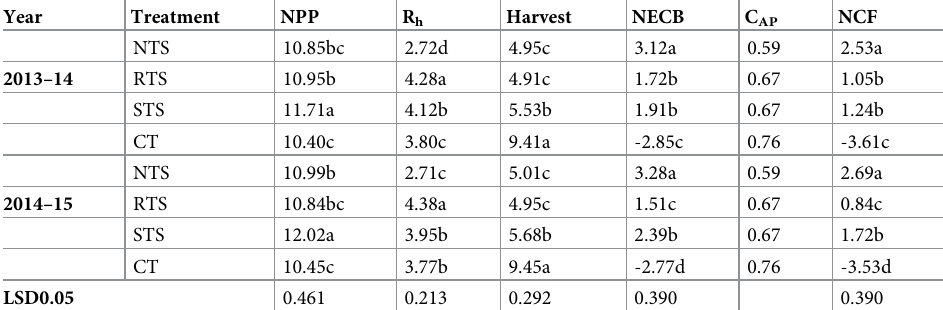
Table 4. The agro-ecosystem C balance (NCF) and its main components for the annual cycle of wheat-maize rota- tion in 2013–2015 (t C ha -1 yr -1 ).